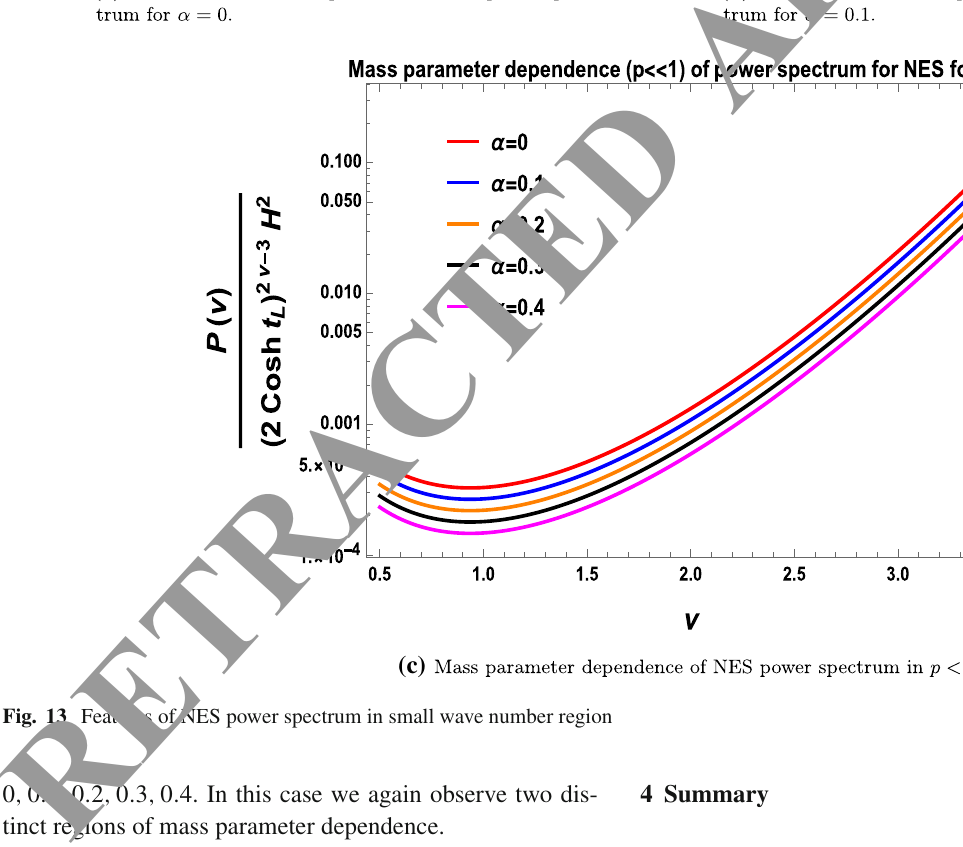
Fig. 13 Features of NES power spectrum in small wave number region